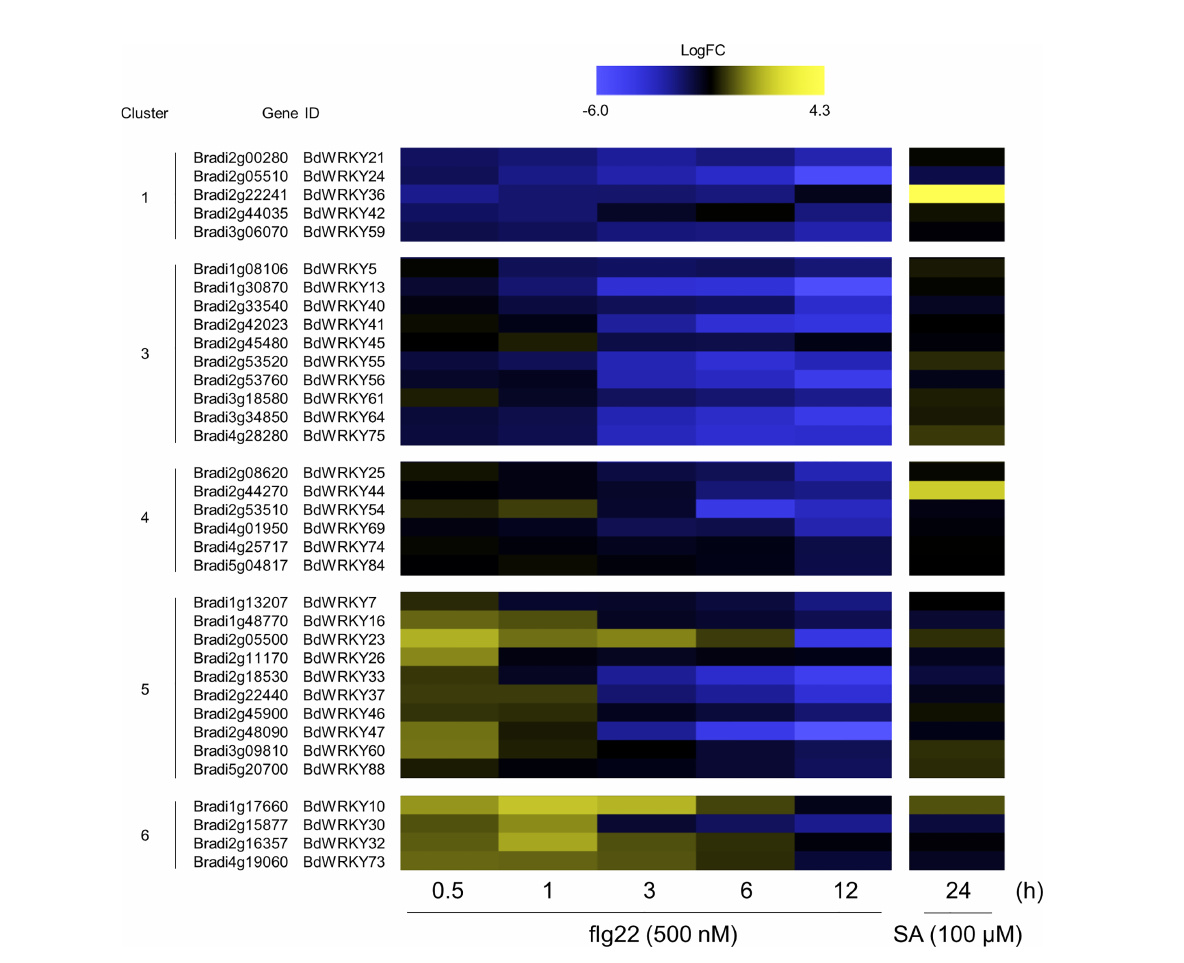
FIGURE 7 Expression patterns of WRKY TF-encoding DEGs identi fi ed in the fl g22-treated Brachypodium distachyon leaf disks. Log2 (fold change) in the expression level of each WRKY gene at 0.5 – 12 h after fl g22 treatment (left) and at 24 h after SA treatment (right; retrieved from Kouzai et al. (2020) compared with the non-treated control was calculated and represented as a heatmap. The higher expression values are shown in yellow color. Data are shown only for clusters 1, 3, 4, 5, and 6, in which signi fi cant over-representations of WRKY genes were